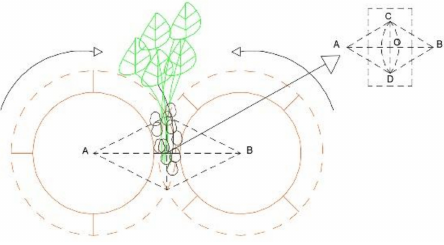
Figure 3. Working schematic of double-roller for picking.